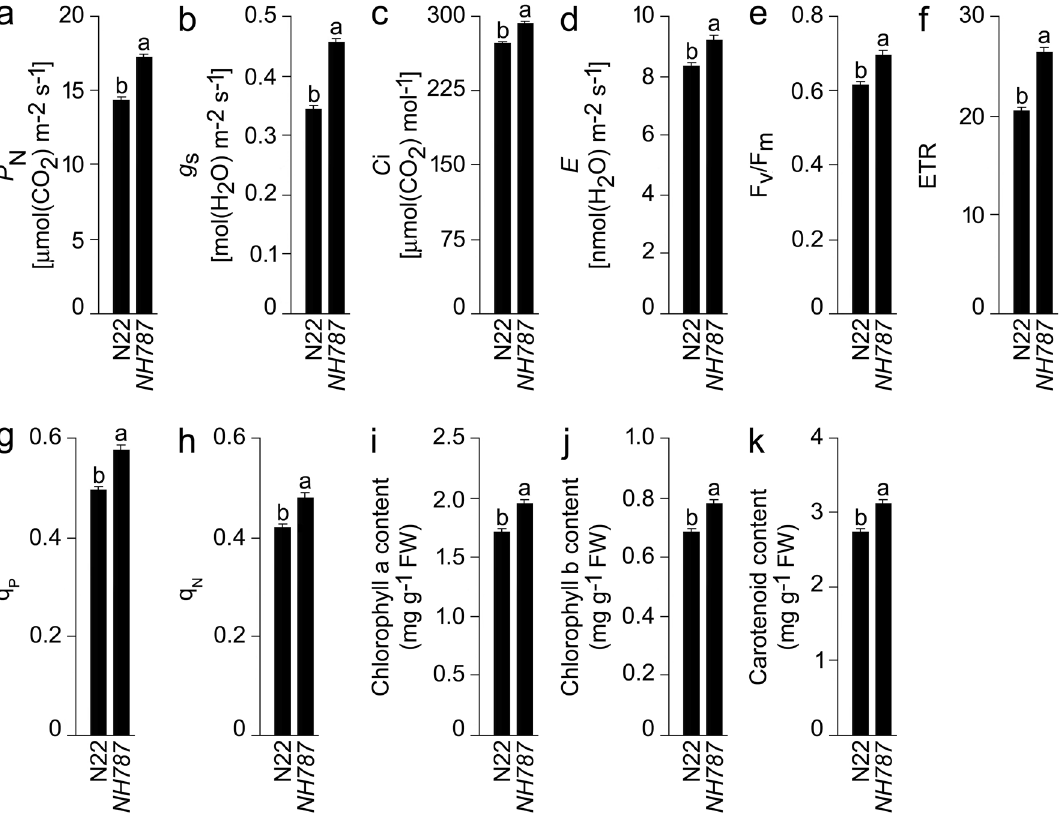
Figure 4. Effects of Pi deficiency on the photosynthetic and fluorescence traits in N22 and NH787 . ( a – k ) Data are presented for ( a ) Photosynthetic rate ( P N ), ( b ) Stomatal conductance ( g s ), ( c ) Intercellular CO 2 concentration ( C i), ( d ) Transpiration rate ( E ), ( e ) Maximum efficiency of PSII photochemistry (Fv/Fm), ( f ) Electron transport rate (ETR), ( g ) Coefficient of photochemical quenching (qP), ( h ) Coefficient of non-photochemical quenching (qN), and contents of ( i ) Chlorophyll a, ( j ) Chlorophyll b, and ( k ) carotenoid. Values ( n = 12) are means ± SE and different letters on the histograms indicate that the means differ significantly ( P < folds), 100-grain weight (40.00%), and yield (6.42 folds) of NH787 compared with N22 (Fig. 3e–i,k,i). However, unfilled spikelets/panicle was significantly higher (73.99%) in N22 than NH787 (Fig. 3j). Similar to P+ condition, under P− condition also Pearson analysis showed a positive and significant correlation of yield with root and vegetative biomass, number of tillers, and filled spikelets/panicle in both N22 and NH787 (Fig. 3h). Photosynthetic and chlorophyll fluorescence traits of N22 and NH787 grown to maturity in potting soil. Pi deficiency adversely affects photosynthetic and chlorophyll fluorescence traits in rice 73,74 . Therefore, photosynthetic and fluorescence traits were assayed in N22 and NH787 grown to maturity under dif- ferent Pi regimes (Fig. S4, Fig. 4). Pi deficiency triggered significant reductions in the photosynthetic rate ( P N ) (N22 [21.84%], NH787 [26.39%]), stomatal conductance ( g s ) (N22 [88.24%], NH787 [42.23%]), transpiration rate ( E ) (N22 [15.31%], NH787 [27.90%]), maximum efficiency of PSII photochemistry (Fv/Fm) (N22 [15.79%], NH787 [8.73%]), electron transport rate (ETR) (N22 [26.69%], NH787 [18.32%]), coefficient of photochemical quenching (qP) (N22 [21.26%], NH787 [11.26%]), and coefficient of non-photochemical quenching (qN) (N22 [28.66%], NH787 [15.60%]) (data not shown). Earlier studies also reported the inhibitory effects of Pi defi- ciency on various photosynthetic and chlorophyll fluorescence traits in the rice genotypes 73,74 , N22 and its EMS mutants 43 . On the contrary, Pi deficiency excreted significant increase in the contents of intercellular CO 2 ( C i) (N22 [26.02%], NH787 [26.32%]), chlorophyll a (N22 [35.18%], NH787 [16.53%]), chlorophyll b (N22 [32.47%], NH787 [28.70%]), and carotenoid (N22 [18.39%], NH787 [7.22%]) (data not shown). The result was consistent with an earlier study showing Pi deficiency-mediated elevated content of C i 74 . Relatively, the augmenting effects of Pi deficiency on chlorophyll a, b, and carotenoid were significantly lower in NH787 compared with N22 (data not shown). Under P+ condition, P N (27.32%), g s (74.66%), C i (3.99%), E (29.02%), Fv/Fm (3.79%), ETR (15.22%), qN (14.03%), and contents of chlorophyll a (32.74%), chlorophyll b (16.75%), and carotenoid (21.35%) were significantly higher in NH787 than N22 (Fig. S4A–J). A similar trend was also observed during Pi defi- ciency where these values ( P N [19.90%], g s [31.97%], C i [4.24%], E [9.83%], Fv/Fm [12.48%], ETR [28.39%], qP [15.67%], qN [2.46%], and contents of chlorophyll a [14.42%], chlorophyll b [13.43%], and carotenoid [9.91%]) were significantly higher in NH787 compared with N22 (Fig. 4a–k). The analyses revealed that NH787 main-